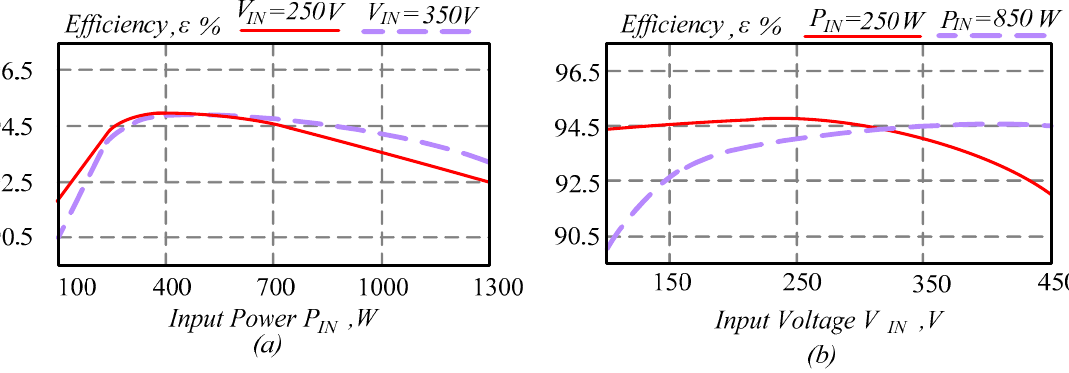
Figure 13. Efficiency versus input power in unidirectional mode with constant input voltage ( a ), efficiency versus input voltage with constant input power ( b ).